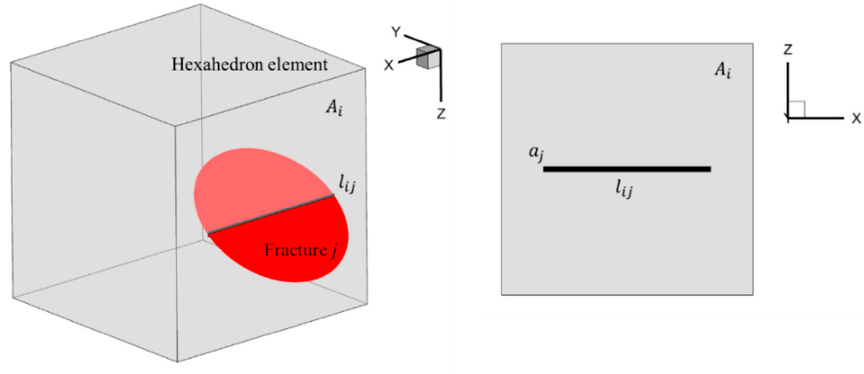
Figure 4. The contribution of one fracture permeability to equivalent permeability of a finite element (reproduced from [13]).